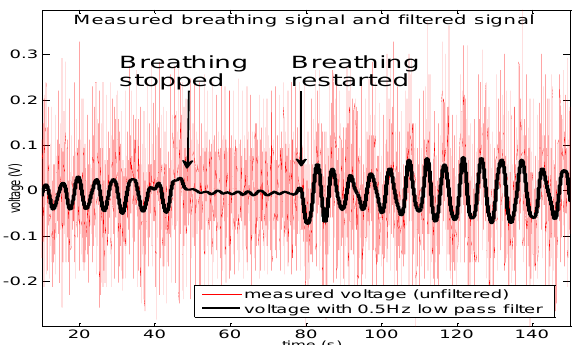
FIGURE 1: Graph of original and filtered pressure measurements from the